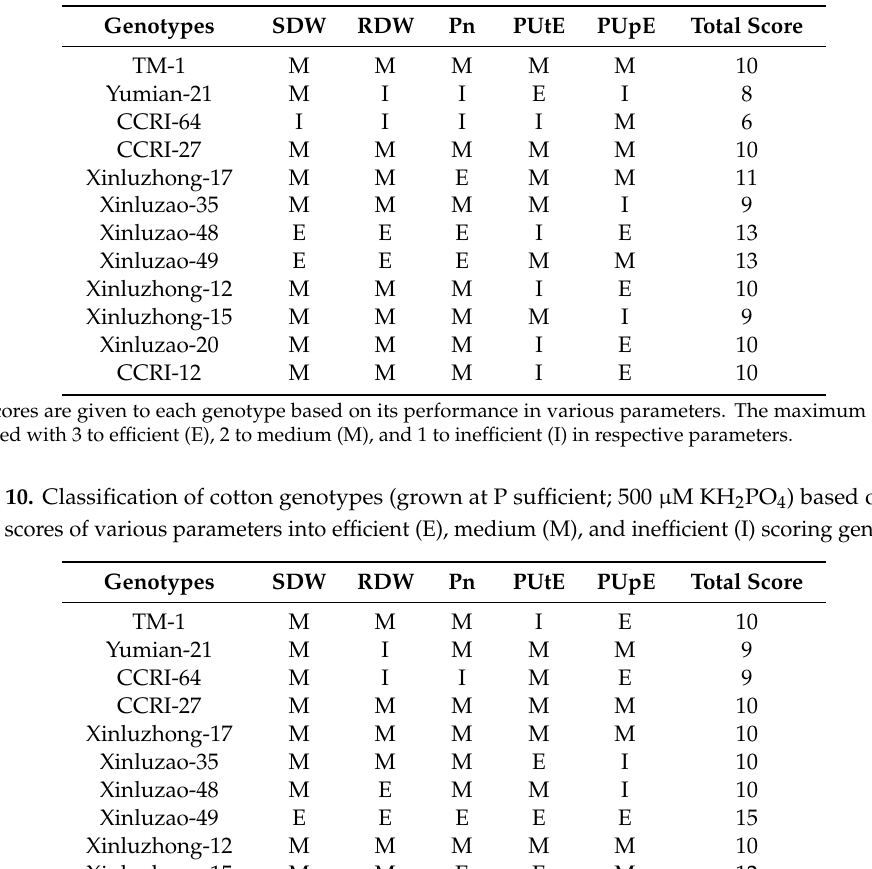
Table 9. Classification of cotton genotypes (grown at P deficient; 10 µ M KH 2 PO 4 ) based on their index scores of various parameters into e ffi cient (E), medium (M), and ine ffi cient (I) scoring genotypes.